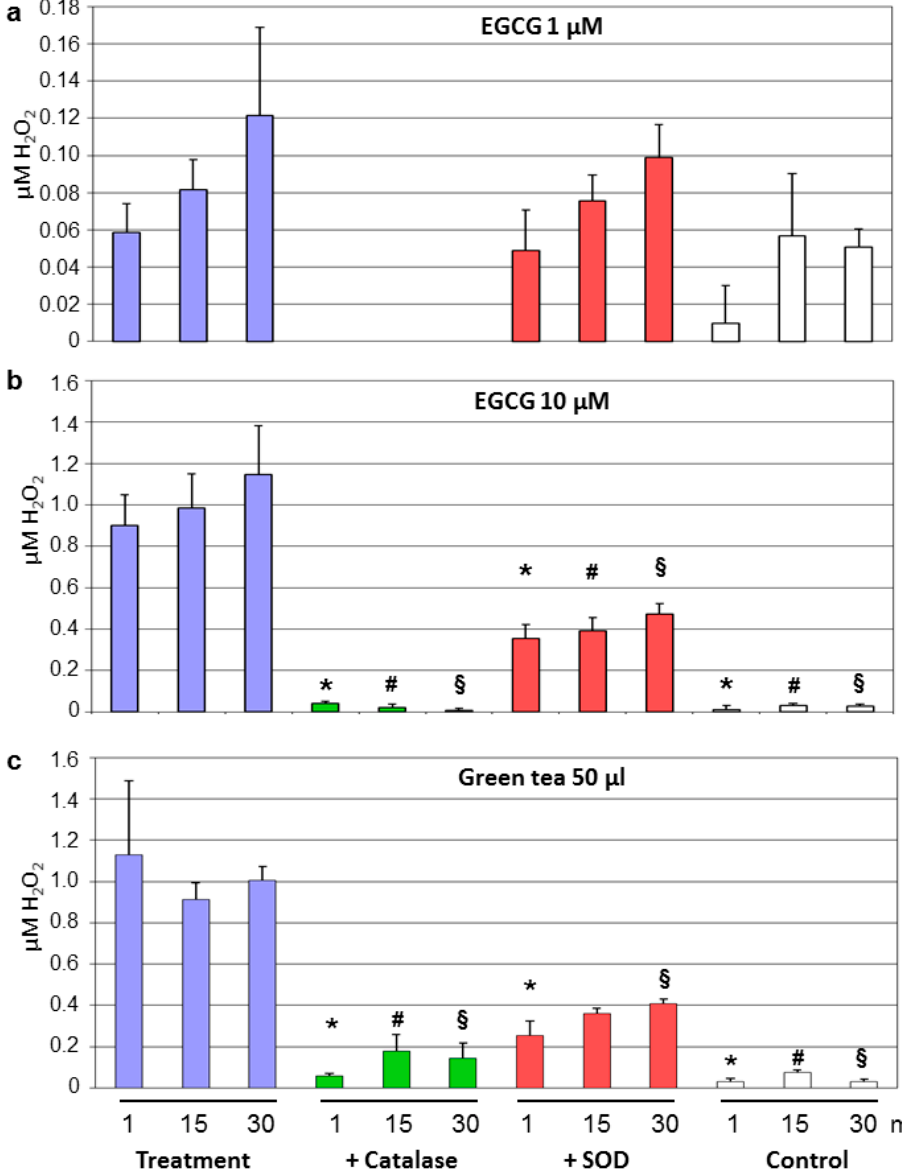
Figure 4. H 2 O 2 production by EGCG and green tea. A single dose of EGCG (1 µM ( a ) or 10 µM ( b ) or of 50 µL green tea ( c ) was applied. Aliquots were taken after the indicated time points and concentrations of hydrogen peroxide in the Krebs–Henseleit buffer were determined. Experiments were performed with or without 200U/mL catalase or 500U/mL superoxide dismutase (SOD). Krebs–Henseleit buffer without any treatment served as controls. Data are means ± SEM from n = 4 experiments. * p < 0.05 compared to treatment without antioxidant enzymes after 1 min; # p < 0.05 compared to treatment without antioxidant enzymes after 15 min; § p < 0.05 compared to treatment without antioxidant enzymes after 30 min. The H 2 O 2 levels for 1 µ M EGCG + catalase were below the detection limits. Both concentrations of TF3 (0.5 and 2 µ M) increased H 2 O 2 levels above the control. Catalase completely inhibited H 2 O 2 production, while SOD was without a consistent e ff ect (Figure 5a,b). 2 µ